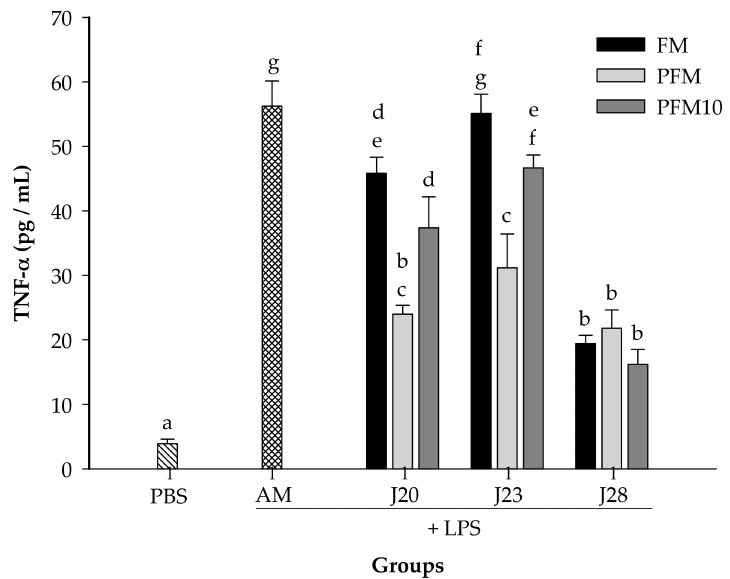
Figure 5. Serum concentrations of TNF- α . Groups were daily administrated for 4 weeks with fermented milk (FM), pasteurized fermented milk (PFM), fractions <10 kDa of PFM (PFM10) with Lactobacillus J20, J23 or J28; after 4 weeks, rats were injected with LPS, and sacrificed after 6 h post-injection. Control groups included: acidified milk (AM) injected with LPS; or phosphate buffer saline (PBS) without LPS. Bars represent means ± SE ( n = 6). Different letters indicate significant differences ( p < 0.05) among all groups.